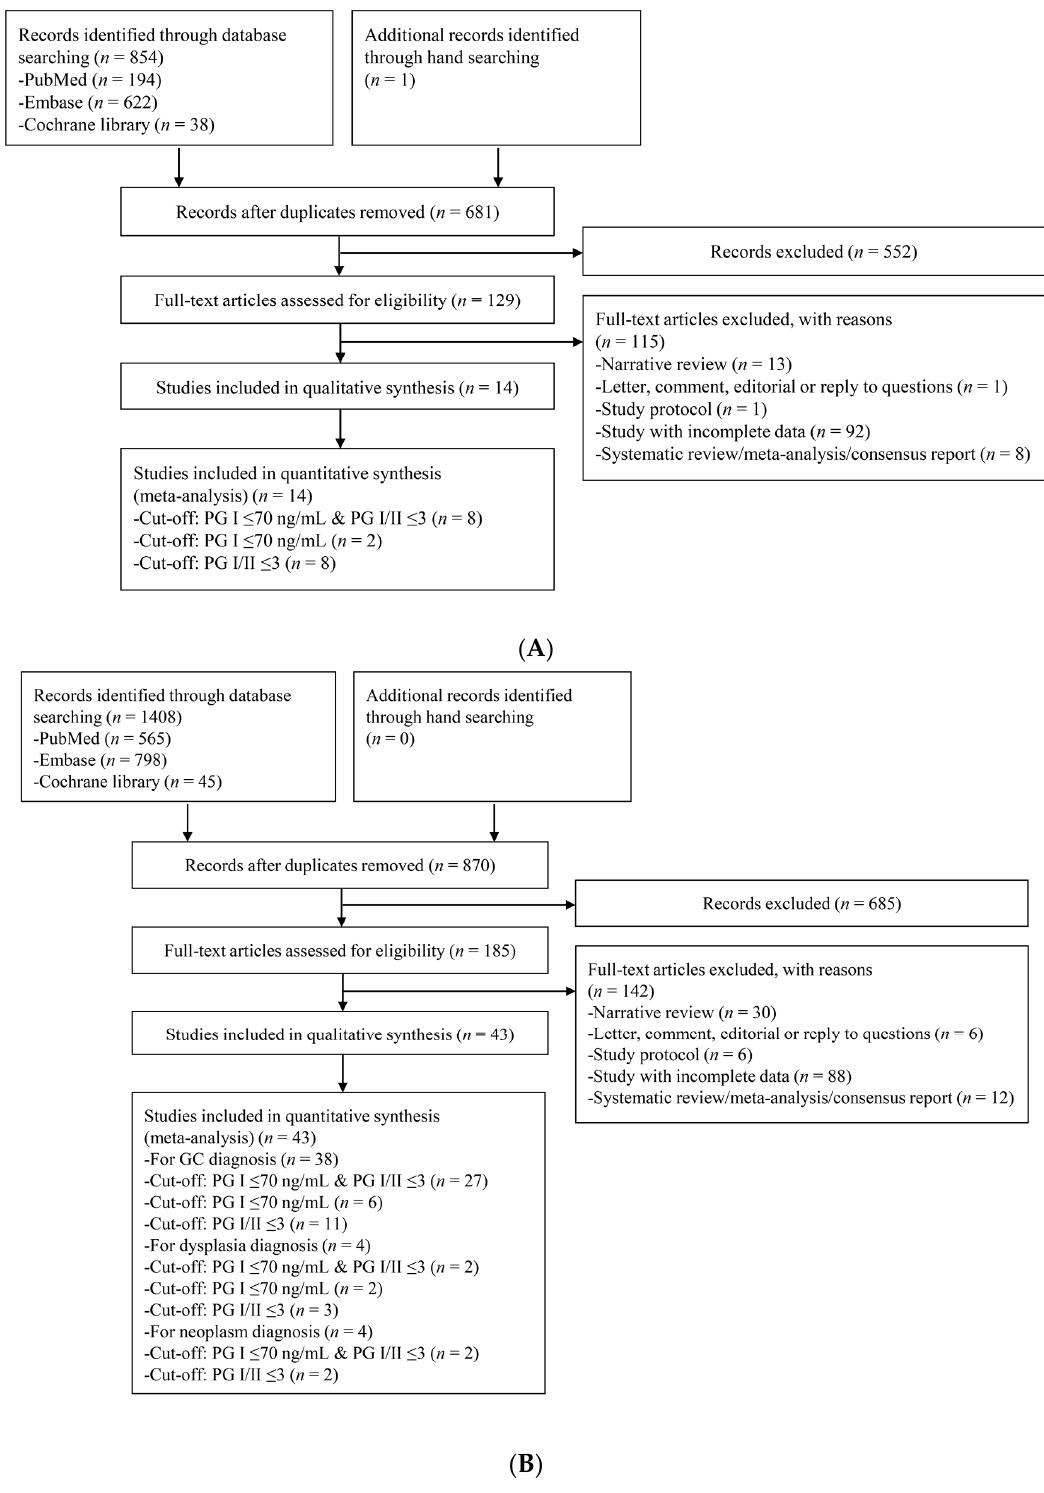
Figure 1. Flow diagram of the identification of relevant studies. ( A ) For the diagnosis of CAG, ( B ) For